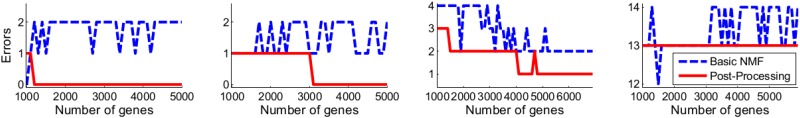
Clustering errors as a function of the number of features (genes) for datasets Leukemia (k = 2), Leukemia (k = 3), CNS (k = 4) and Medulloblastoma (k = 2) respectively.On each of these datasets, the Basic NMF (and the post-processing method using the maximum norm together with the filter) is run on subsets of the full data with 1000 + 100d of most highly varying genes (d = 0, 1, 2, 3, …). Results are shown as continuous lines for clarity. Clustering error, the number of samples improperly clustered by an algorithm. Here the Basic NMF is the one minimizing a KL divergence in Eq (1).